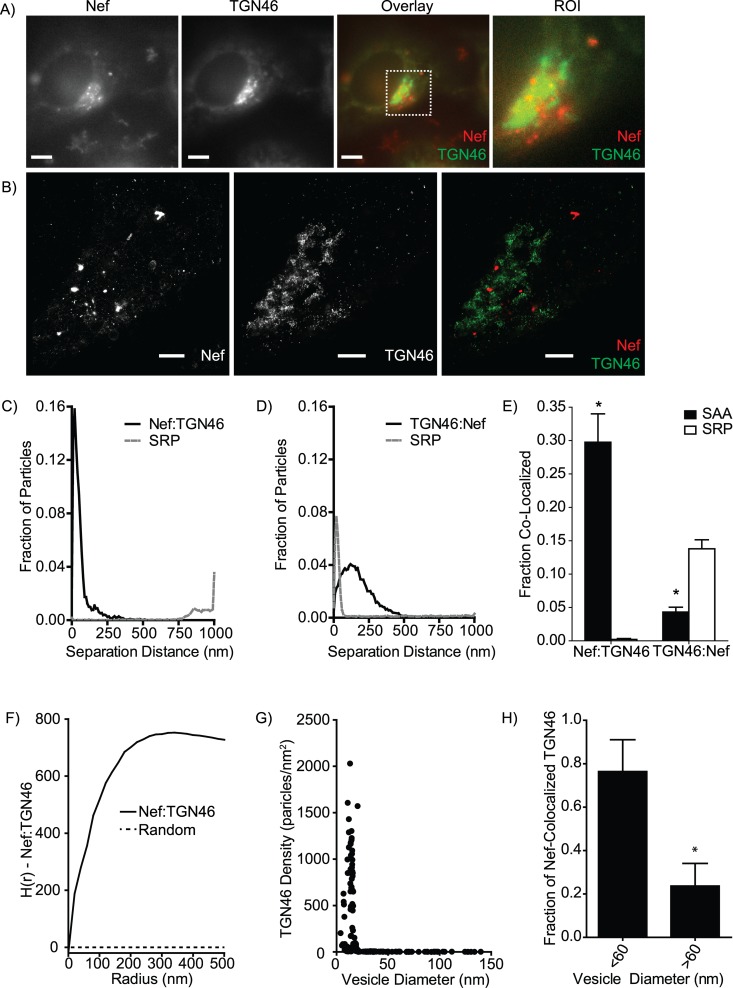
Combining multiple analyses to characterize inter-protein interactions.(A) Conventional microscopy images of dimerized Nef, detected by bimolecular fluorescence complementation (Nef, red) and the Golgi trafficking regulator TGN46 (green). ROI has a Mander’s colocalization ratio (Nef:TGN46) of 0.842. (B) GSDM image of the ROI indicated in panel A. (C-D) SAA plots and (E) quantification of Nef interactions with TGN46 (C, E) and the reverse quantification of TGN46 interaction with Nef (D,E). (F) Ripley’s H function analysis of Nef:TGN46 co-clustering. (G) TGN46 density in Nef-containing vesicles of increasing size. Nef-containing vesicles were identified using the OPTICS algorithm, and the density of TGN46 in each Nef-containing vesicle quantified. (H) Fraction of total detected TGN46 in small (<60 nm) and large (>60 nm) Nef vesicles. Images are representative of, and graphs quantify, 8 images collected in two experiments. Data are presented as mean ± SEM (E,H) or are representative plots from single images (C,D,F,G). Scale bars are 2.5 μm (A) or 0.5 μm (B), ROI (A) is 3.94 μm x 3.94 μm. SRP = Simulated Random Positions. * = p<0.05 compared to SRP, paired t-test (E) or vesicles <60nm, Students t-test (H).